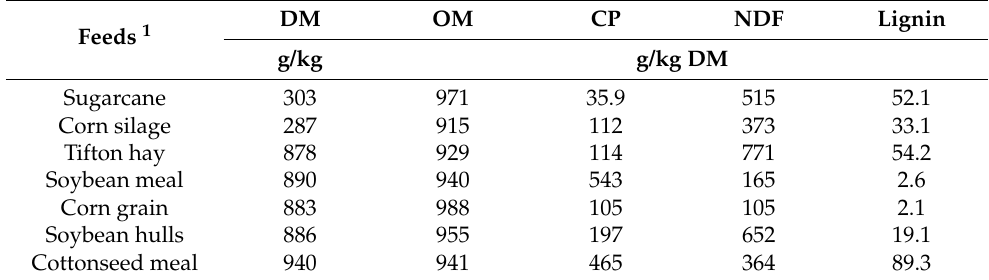
Table 1. Chemical composition of the